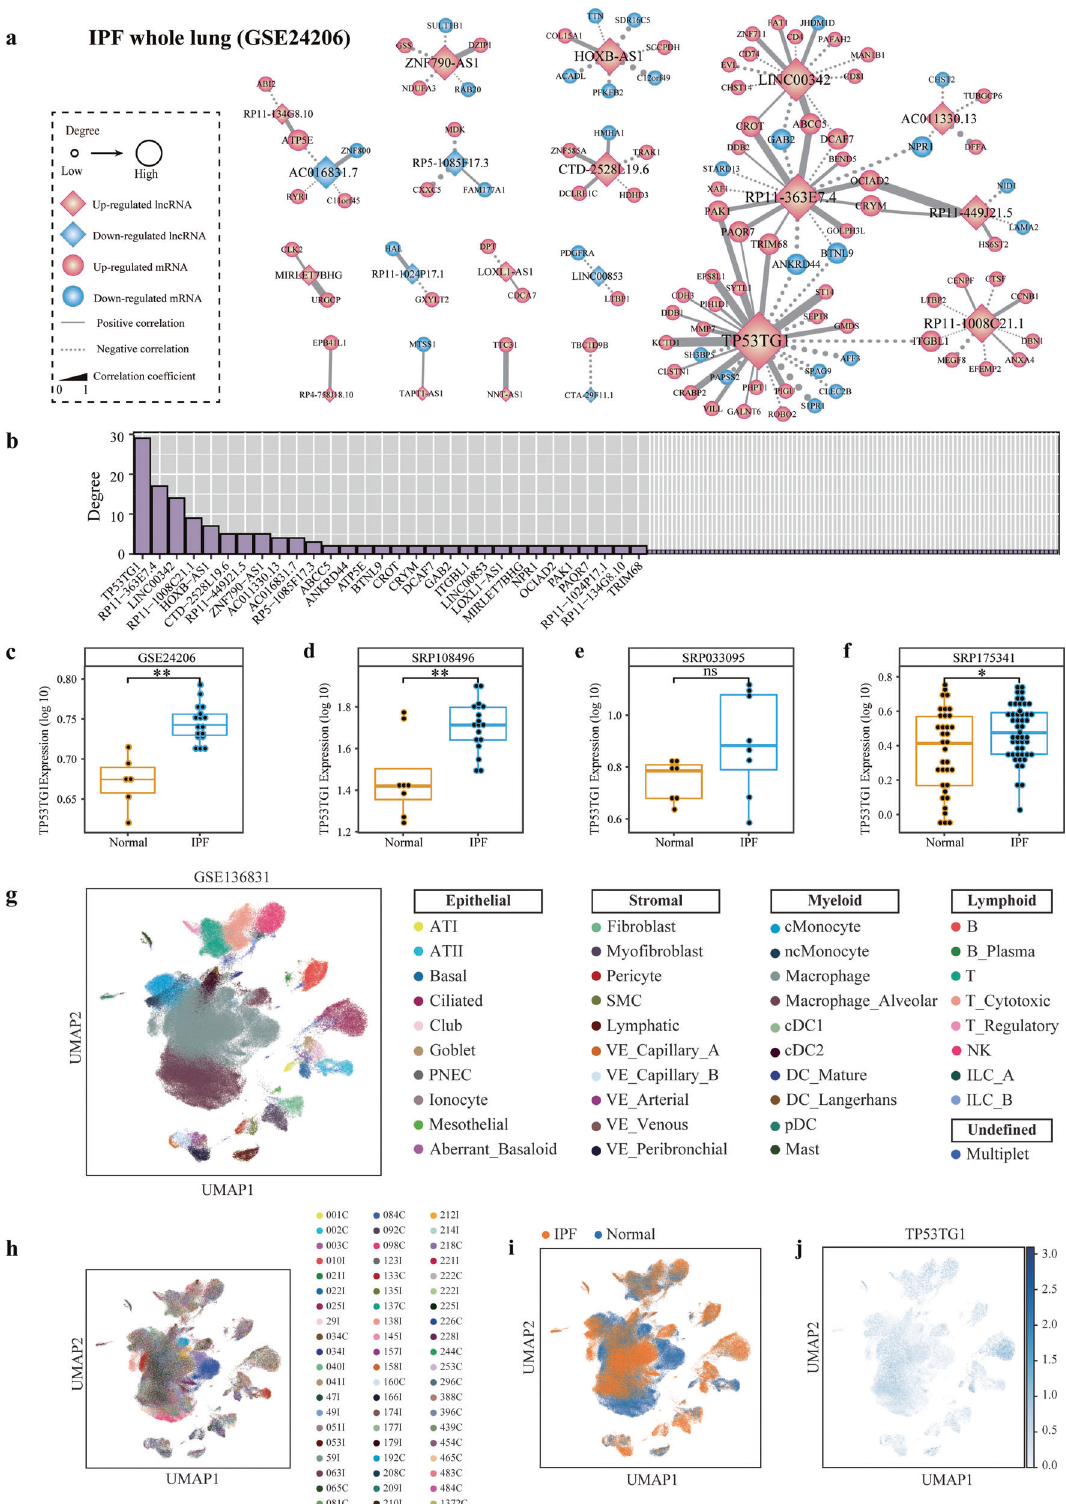
AAV5-TP53TG1 fi ve days after BLM induction and euthanized the mice 21 days after BLM injection (Fig. 6a). After BLM successfully induced pulmonary fi brosis in mice, the mRNA levels of fi brosis- related genes were inhibited by the AAV5-TP53TG1 (Fig. 6b). And the protein expressions of Fn1 and Collagen I was similarly